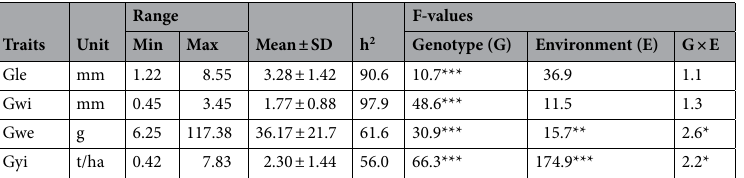
Table 1. Descriptive statistics, broad sense heritability (h 2 ) and F-value of variance analysis for four agronomic traits in a collection of 157 wheat lines. SD Standard deviation, h 2 Broad sense heritability, Gle Grain